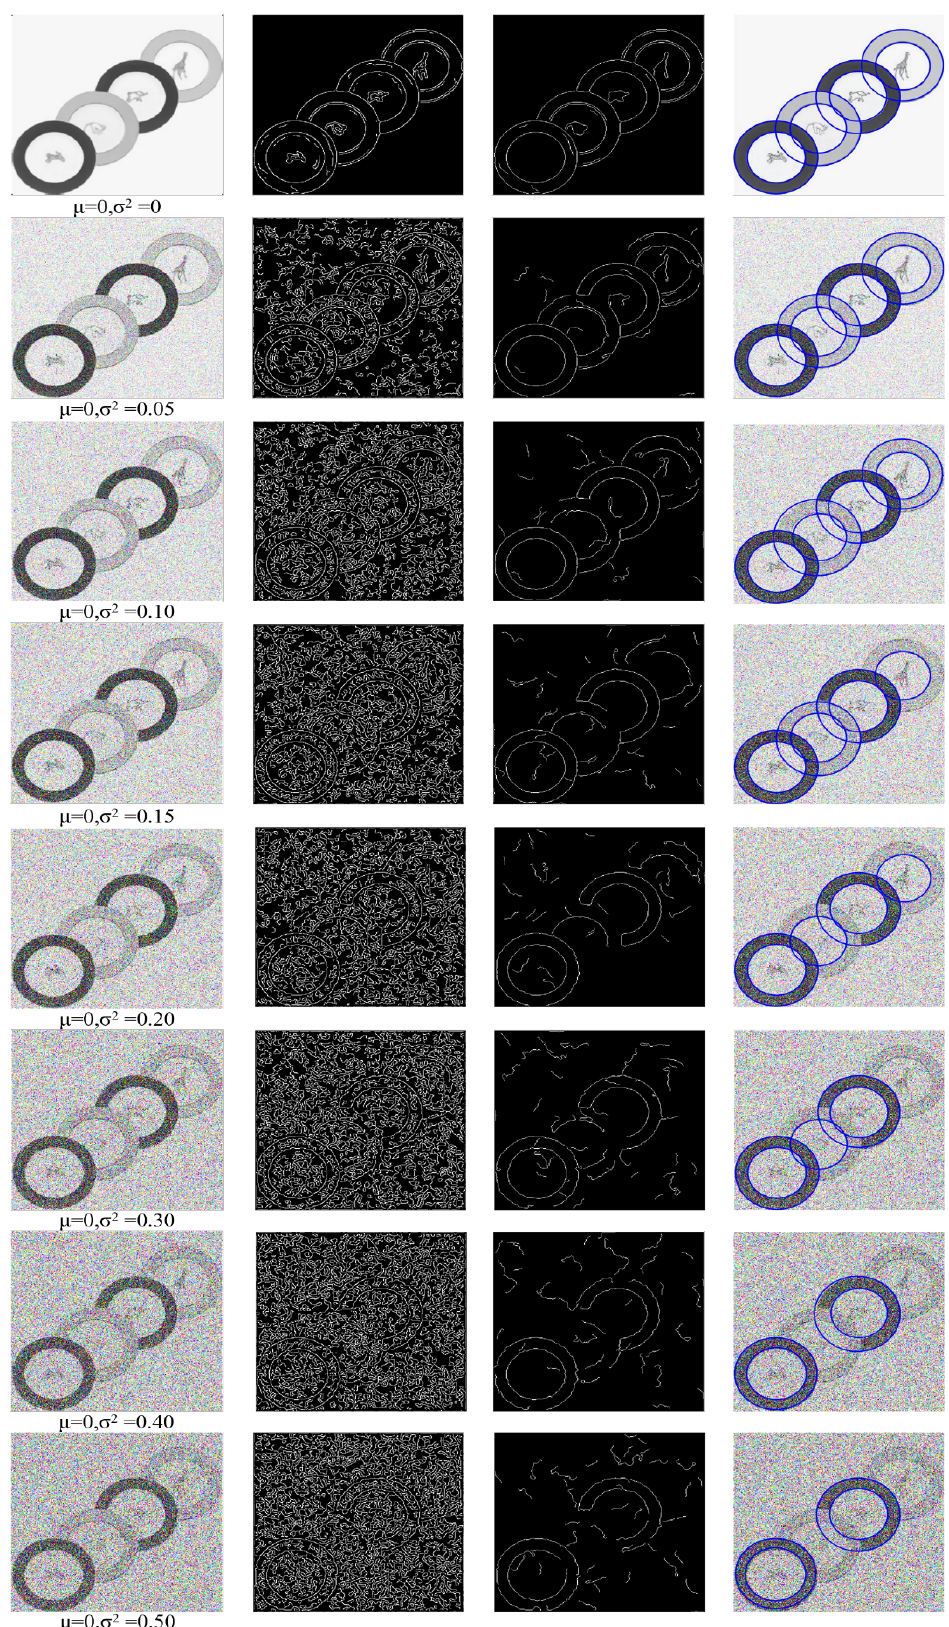
Figure 4. Results of our algorithm under different levels of Gaussian